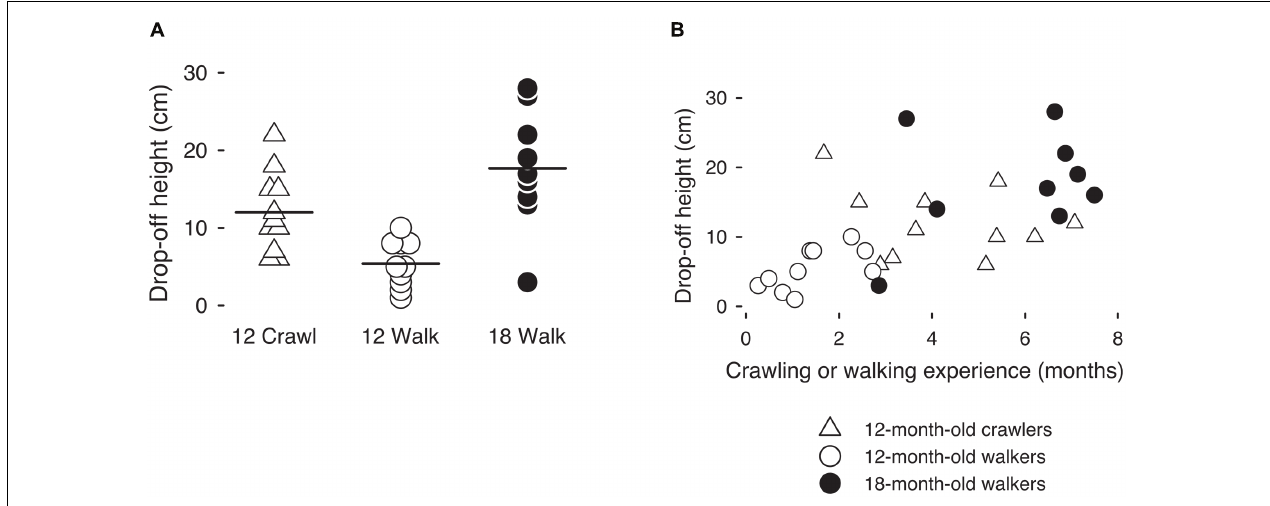
FIGURE 2 | (A) Borderline drop-offs at the limit of infants’ crawling and walking ability for 12-month-old crawlers, 12-month-old walkers, and 18-month-old walkers. Each symbol represents one infant; solid lines represent group means. (B) Relations between posture-specific locomotor experience (months since crawling onset for crawlers, months since walking onset for walkers) and individual differences in borderline drop-offs, at the limit of infants’